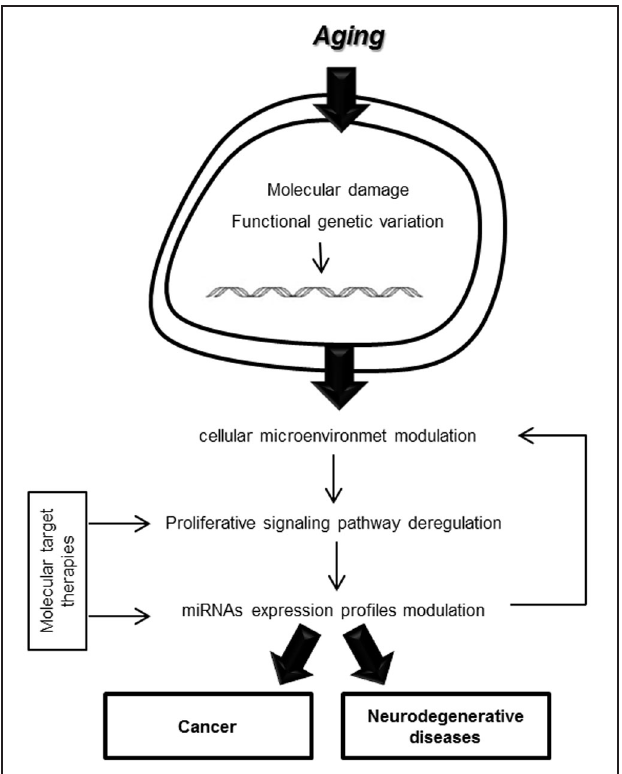
FIGURE 1 | Cellular microenvironment modulation in aging